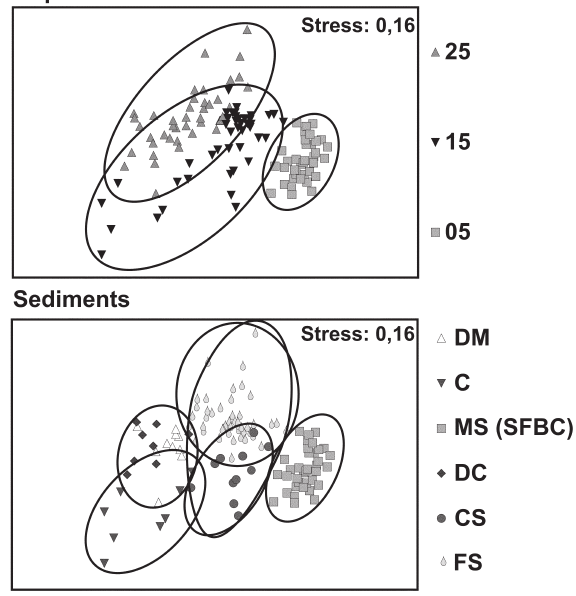
Fig . 5. – MDS analysis of the decapod assemblages according to depth (in meters) and sediments. C: coralligenous, CS: coarse sand, DM detritic of medium sand, DC: detritic of coarse sand, FS: fine sand, and MS: medium